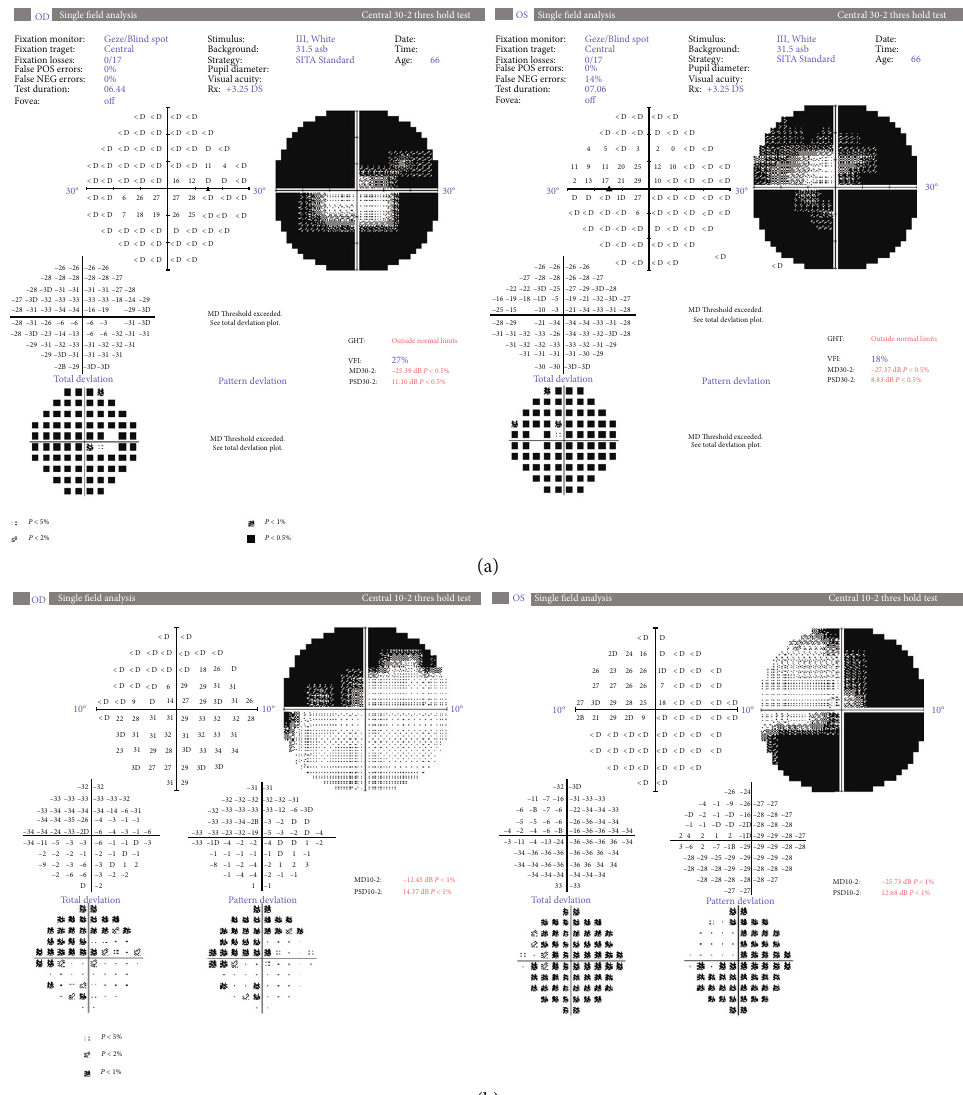
Figure 2: 30-2 (a) andcentral 10-2 (b) visual fi eldplots of both eyes of the patientshowingtubular fi elds with small,central remnantislandsof